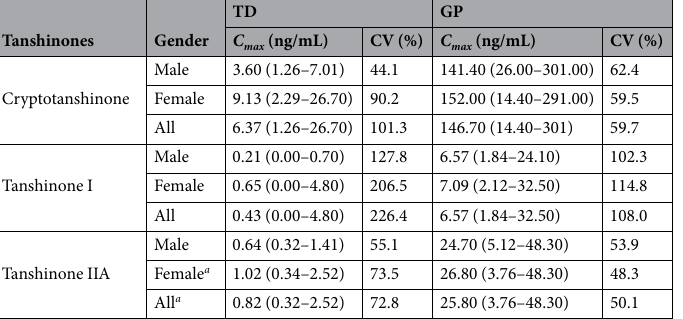
Table 3. Individual variance of C max of tanshinones after administration of GP and TD of SM. Data are expressed as mean (range). a Data of subject 13 was excluded (outlier calculated by F-test). SM Salvia miltiorrhiza , TD traditional decoction of Salvia miltiorrhiza , GP granular powder of Salvia miltiorrhiza , C max peak plasma concentration, CV coefficient of